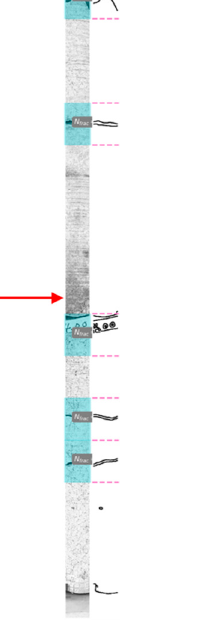
Figure 4. Example of detecting fractures from a grayscale core image.